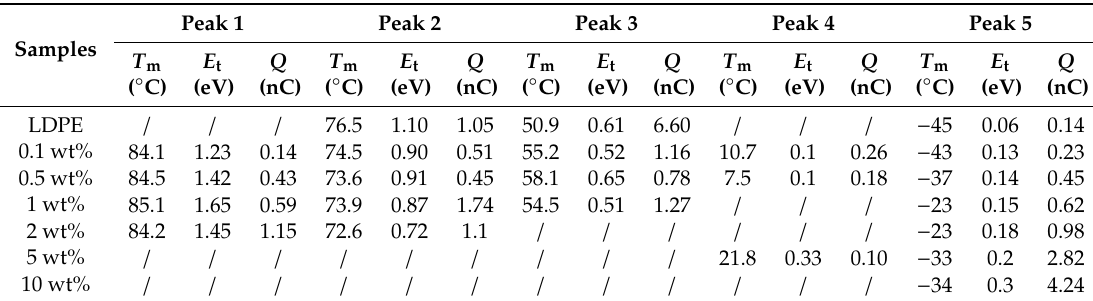
Table 1. Trap parameters in LDPE/TiO 2 nanocomposites.